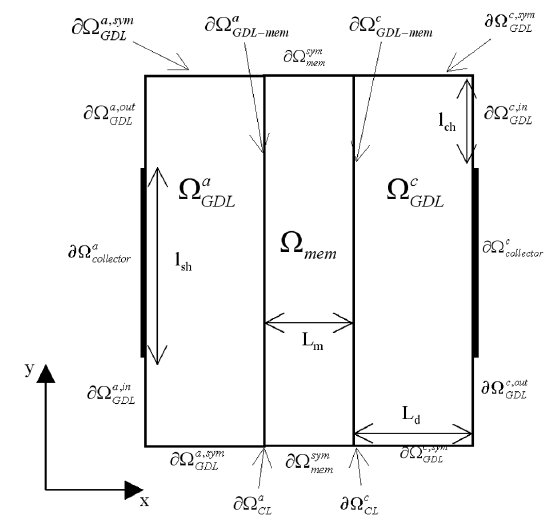
Figure 3. Model regions (  ) and model boundaries (  )